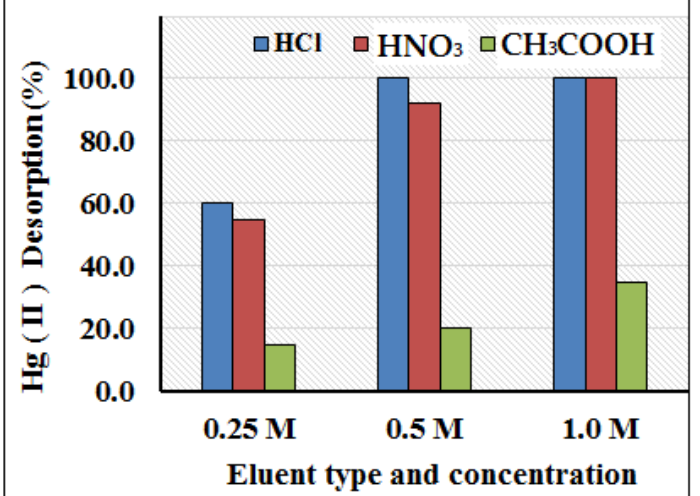
Figure 10. Effect of type and concentration of eluting agents on the desorption of Hg(II) (experimental conditions: sample volume 100 mL; pH = 6.0; flow rate 8 mL min −1 ; Hg 2+ 100 mg L −1 ).